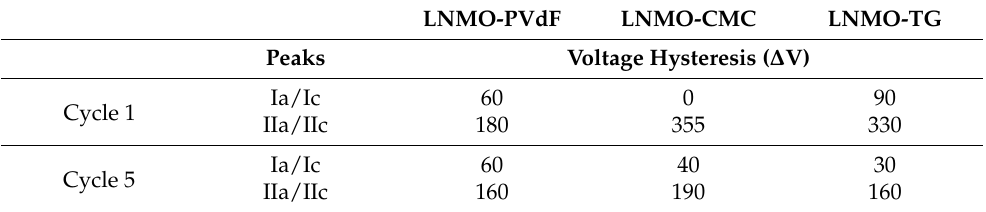
Table 1. Voltage hysteresis ( ∆ V) between main oxidation/reduction peaks in CV for the first and the fifth cycle for LNMO-PVdF, LNMO-CMC, and LNMO-TG. Ia/Ic and IIa/IIc refer to the main oxidation and reduction peaks of manganese and nickel,